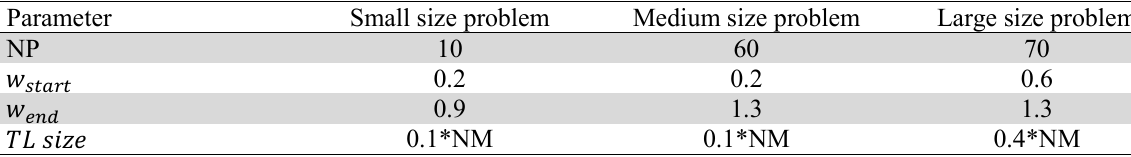
Tuned value of PSOb’s parameters